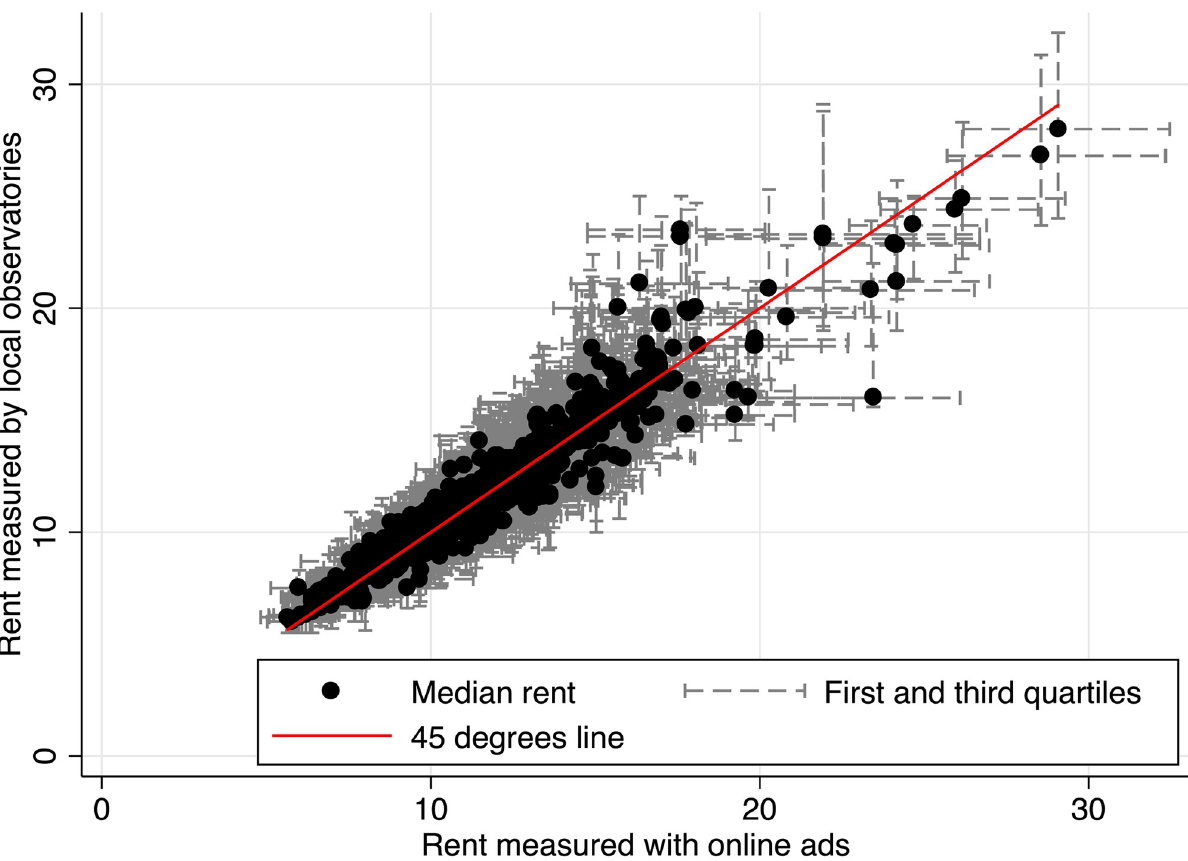
Fig 4. Comparison of the rent distribution between OLL and ads, 2017. Note: The correlation coefficient is 0.95, When estimating Rent with OLS, the estimate of β is 1.029 (95% CI 0.92 1.13) with a clustered standard error of 0.038.